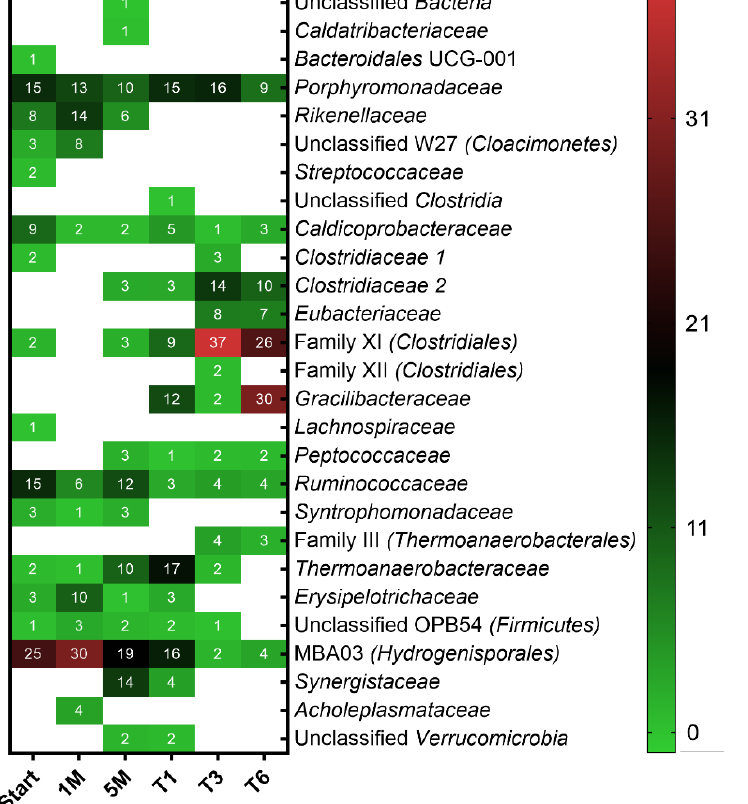
Figure 3. Bacterial community structure in different stages of the enrichment. Taxa with relative abundances less than 1% were filtered out from all samples. Numbers represent the relative abundance in percent and blank spaces indicate the absence of the respective taxa. Mean values of three biological replicates are presented for T1, T3 and T6 whereas single values are shown for Start, 1M and 5M.